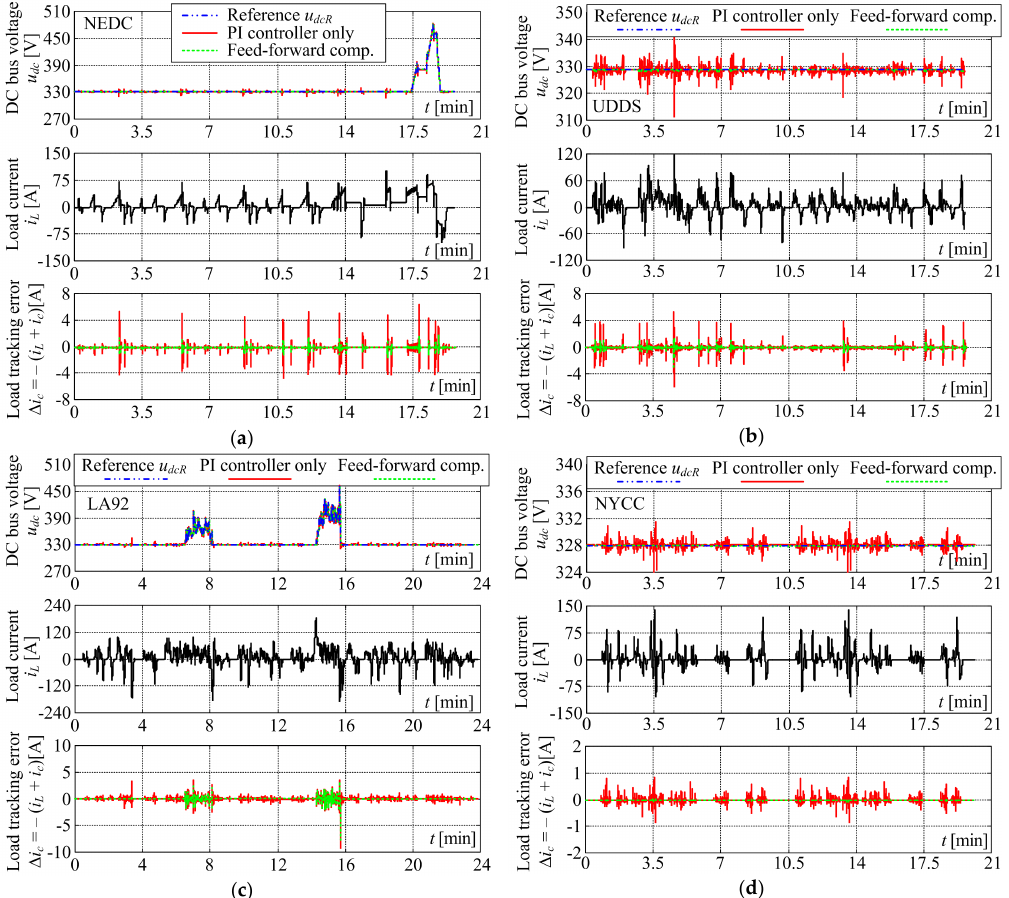
Figure 12. DC bus voltage, load current responses and load current tracking error traces obtained by means of vehicle simulation model for different certification driving cycles: NEDC ( a ), UDDS ( b ), LA92 ( c ) and NYCC ( d ).